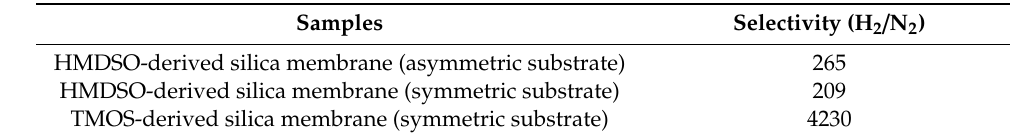
Table 1. Influence of the substrate to the selectivity (H 2 / N 2 ) of silica membranes. The membranes were